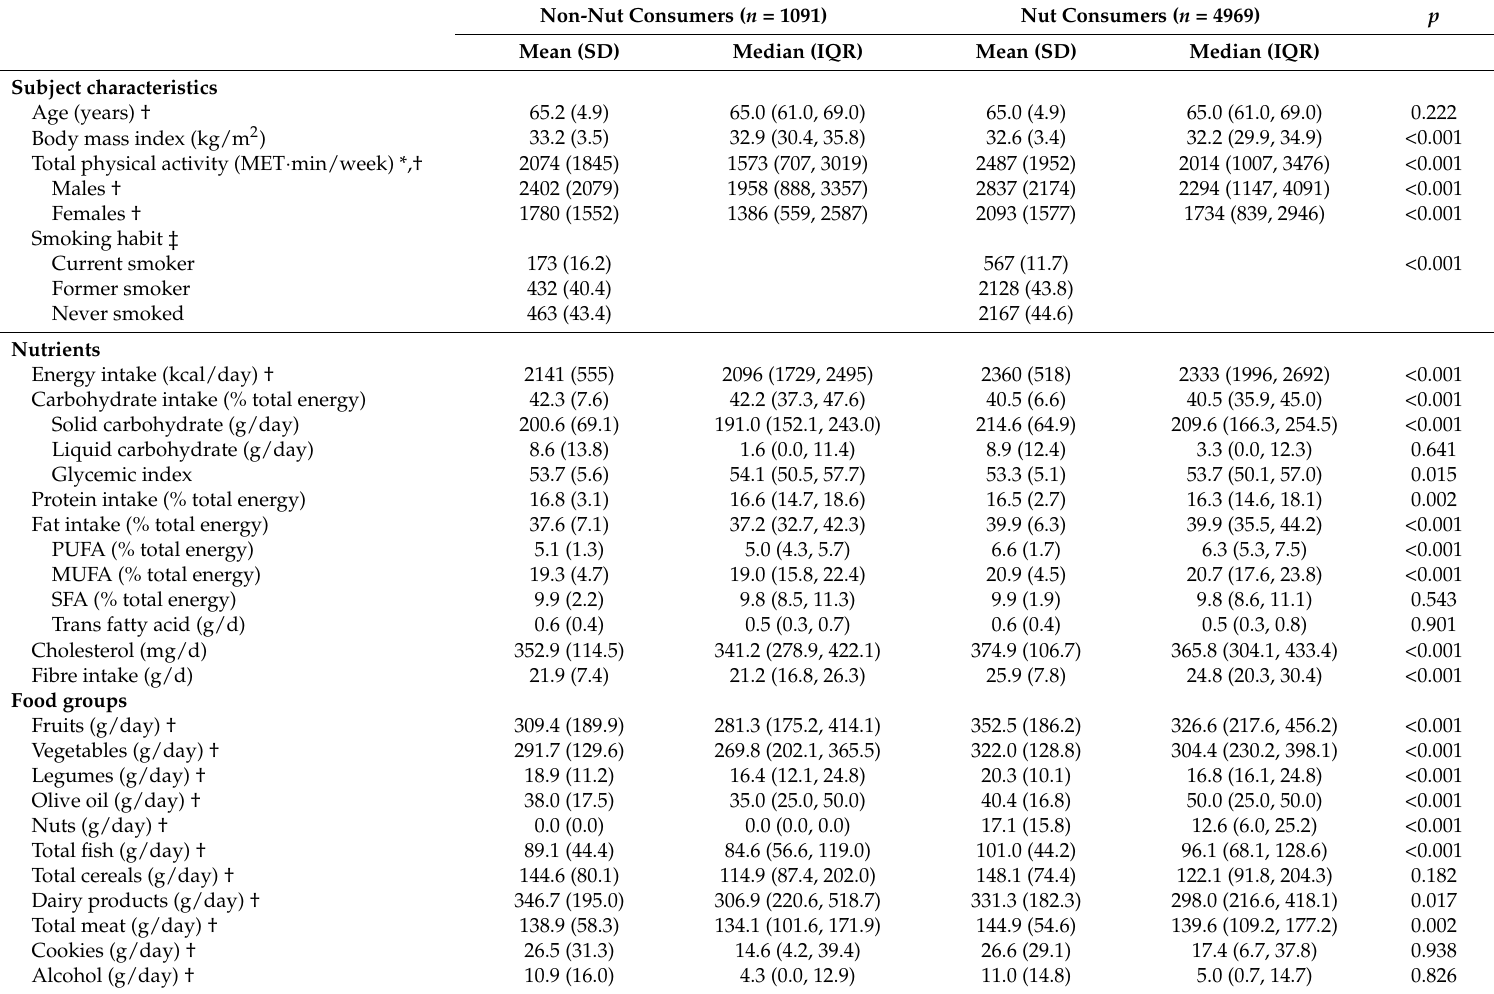
Table 1. Lifestyle and dietary characteristics according to nut